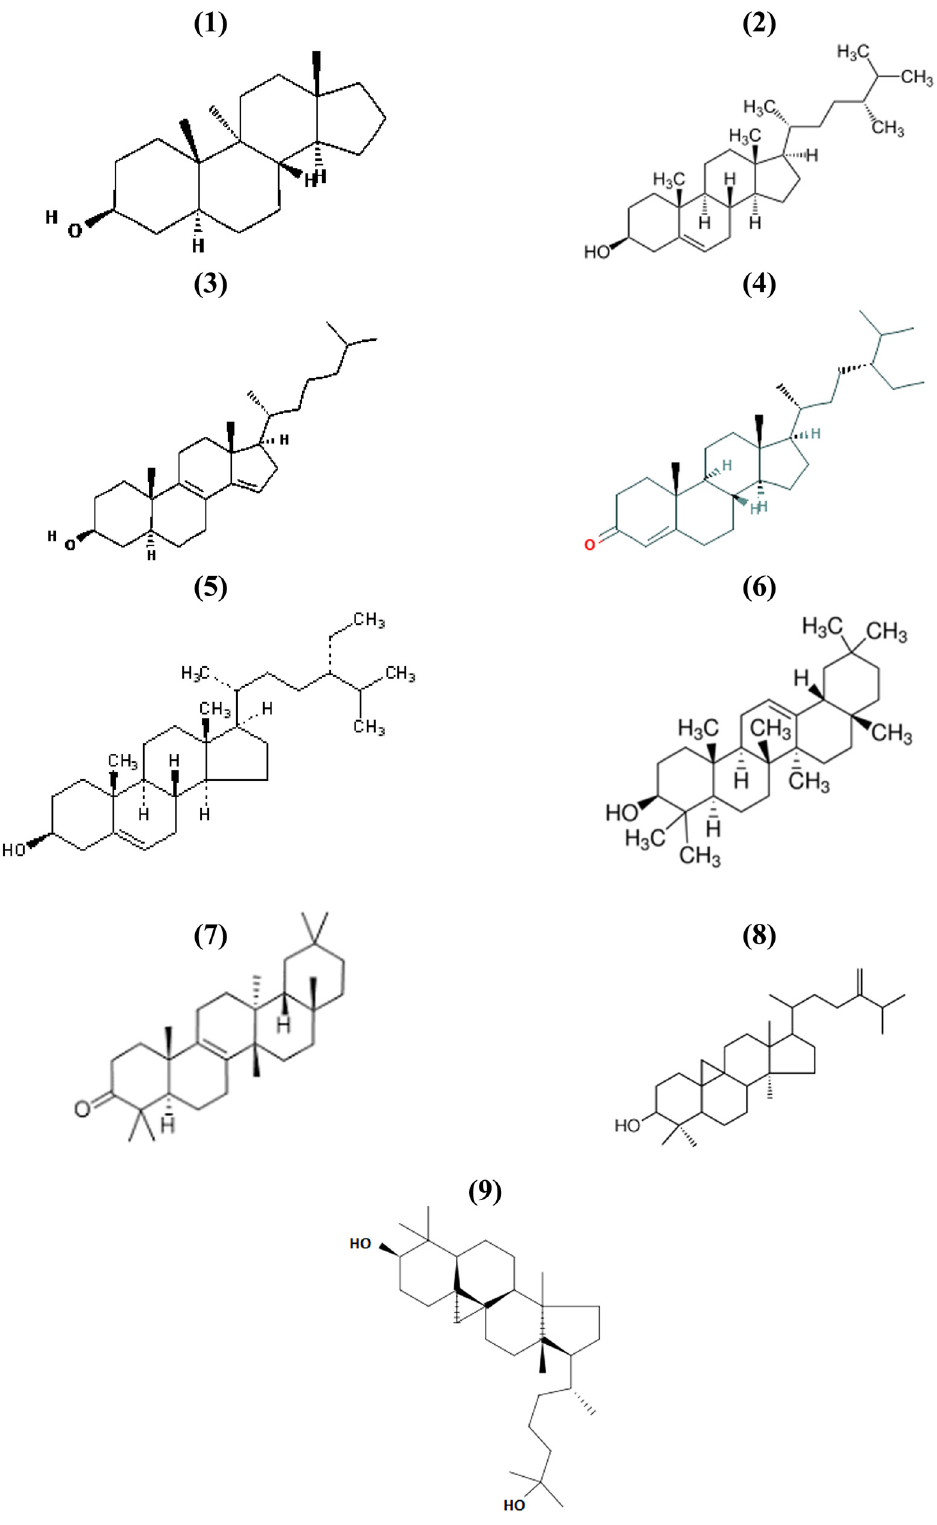
Figure 4: Chemical structures of identi fi ed steroid compounds: ( 1 ) 9 - methyl -( 3 β ,5 α )- androstane - 3 - ol, ( 2 ) 3 β - campesterol, ( 3 ) 3 β ,5 α - 4,4 - dimethylcholesta - 8,14 - dien - 3 - ol acetate, ( 4 ) stigmast - 4 - en - 3 - one, ( 5 ) γ - sitoesterol, ( 6 ) β - amyrin ( olean - 12 - en - 3 β - ol ) , ( 7 ) D:C - friedoolean - 3 - one ( multi fl uorenone ) , ( 8 ) 24 - methylencycloartanol, ( 9 ) 3 β - cycloartane - 3,25 -